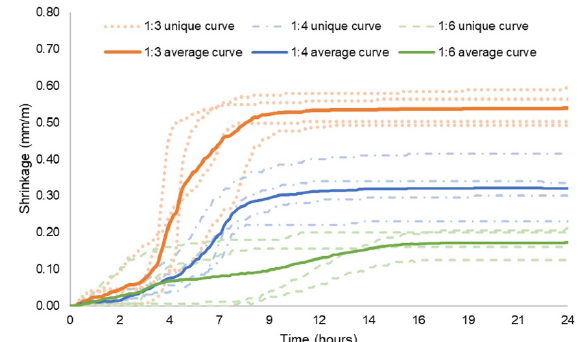
Figure 9. Early shrinkage curves of exposed to air samples. NOTE: dotted lines indicate individual tests, and continuous ones are their respective average curves.